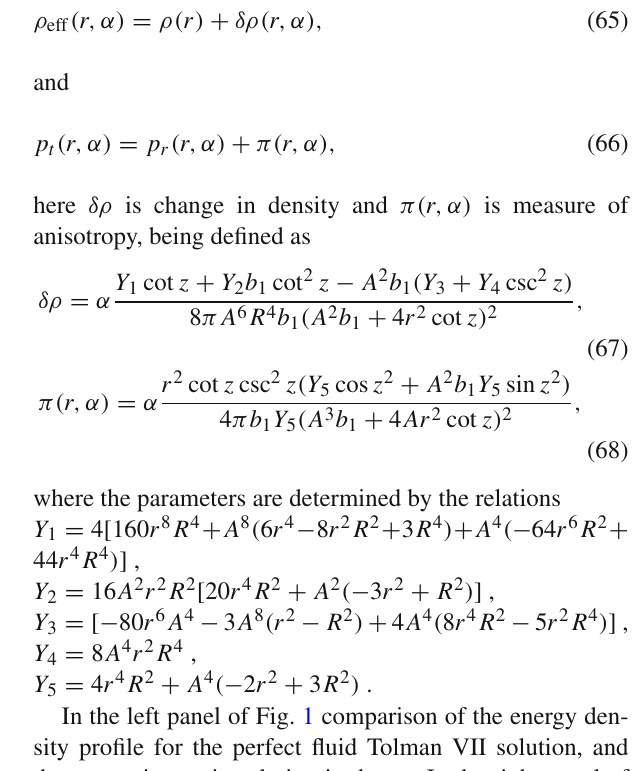
the new anisotropic solution is shown. In the right panel of Fig. 1 comparison of the pressure profile for the perfect fluid Tolman VII and